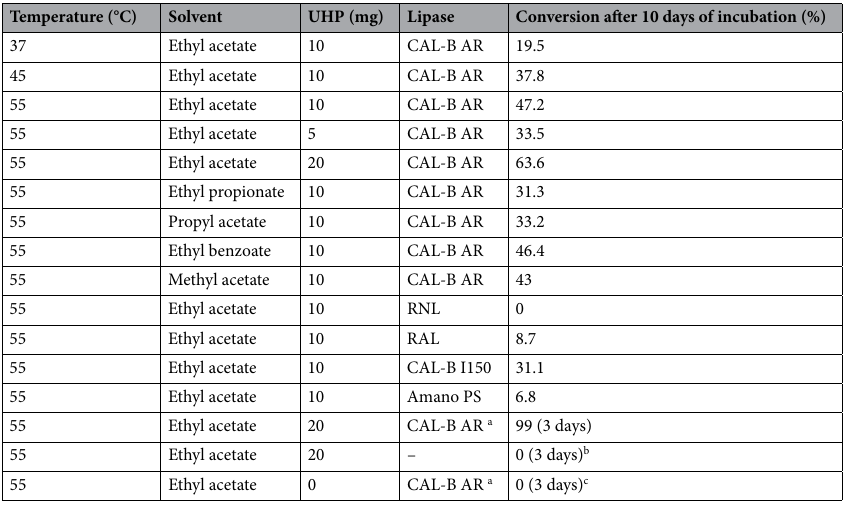
Table 2. The conversion of ketone 1 to lactone 2 after 10 days of reaction performed in different ester solvents. a Doubling of the amount of lipase. b Control without lipase. c Control without